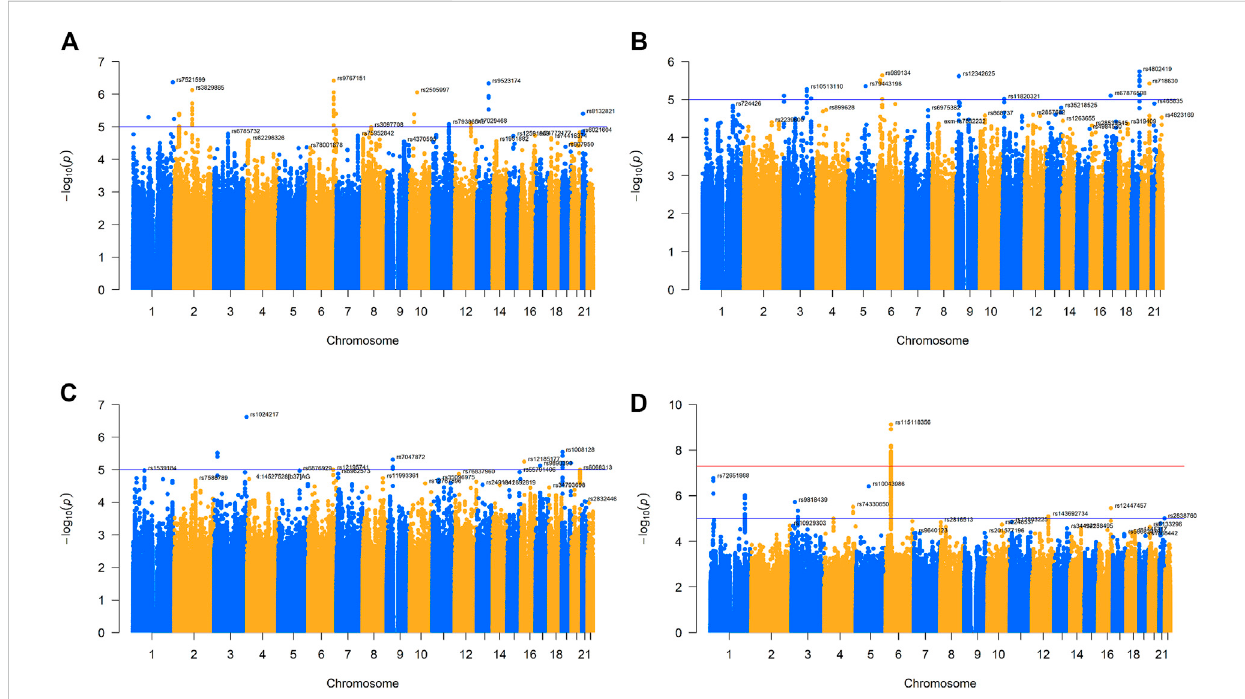
FIGURE 1 Manhattan plot for four GWAS of respiratory infectious diseases. (A) . Manhattan plot of IAV. (B) . Manhattan plot of measles. (C) . Manhattan plot of mumps. (D) . Manhattan plot of